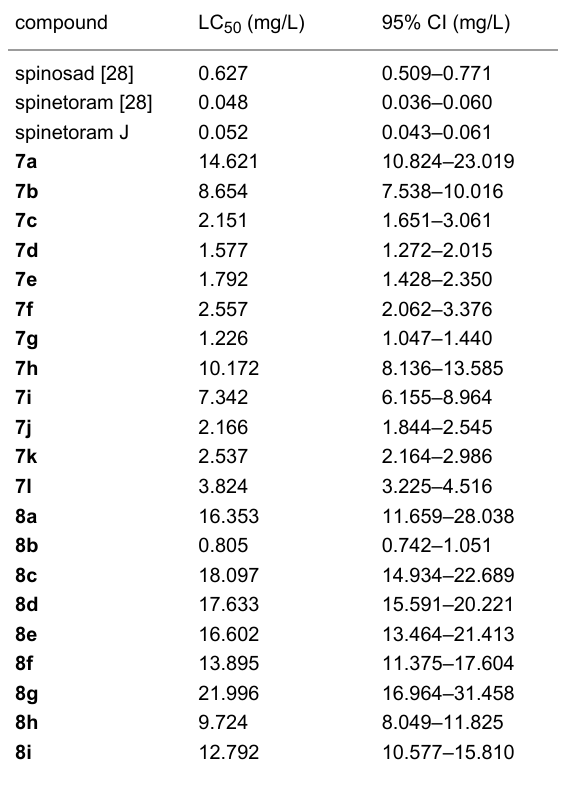
Table 2: The insecticidal activities of spinetoram J and its analogues.